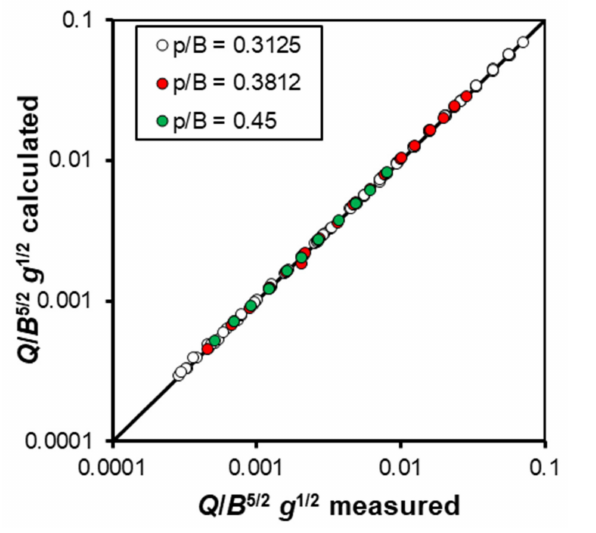
Figure 9. Comparison between the measured Q Equations (23) and (24) for the testing